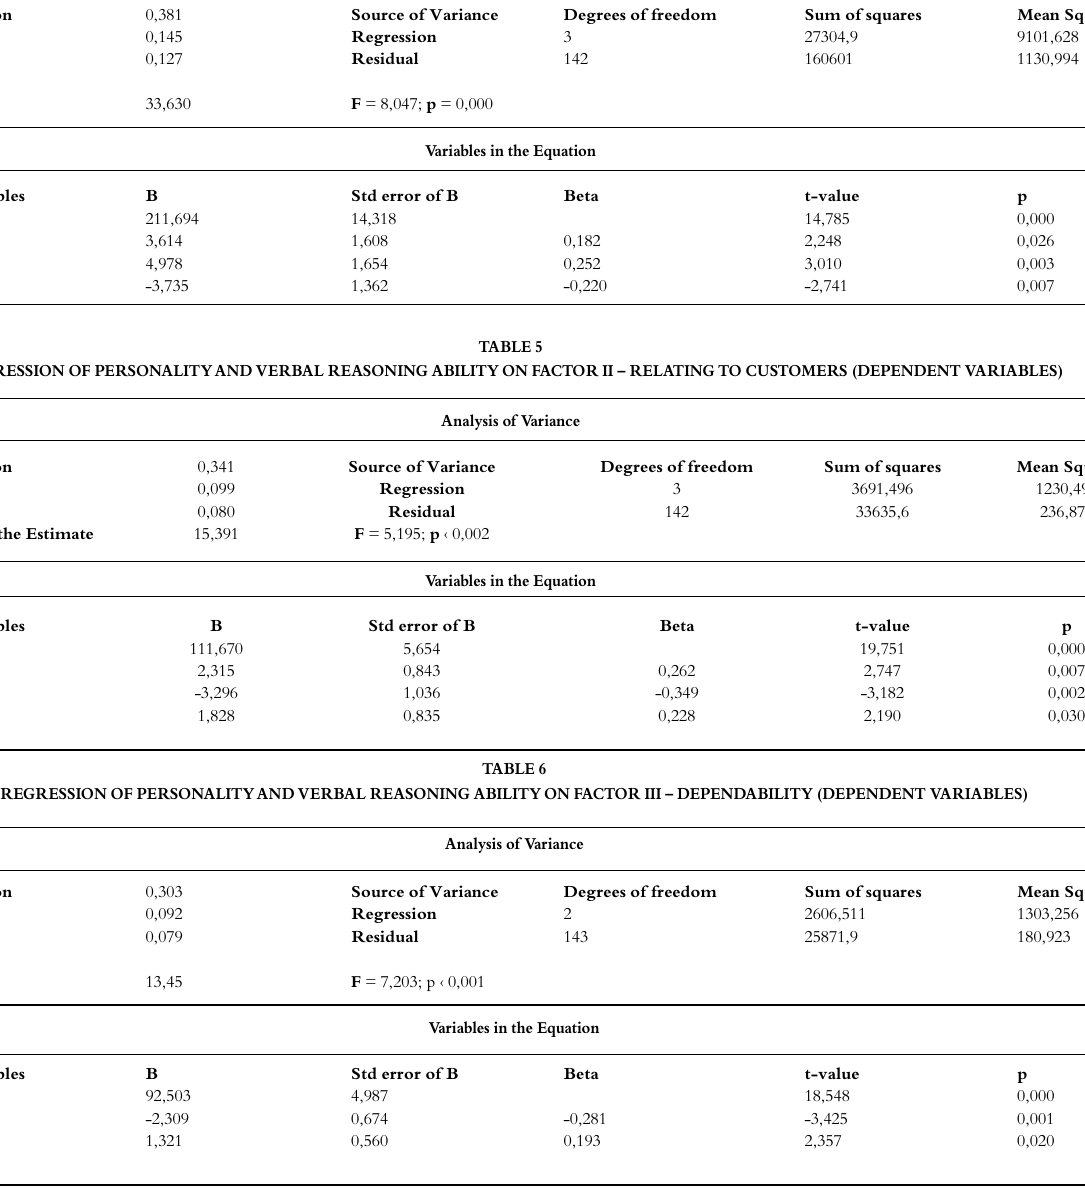
TABLE 4 Analysis of Variance